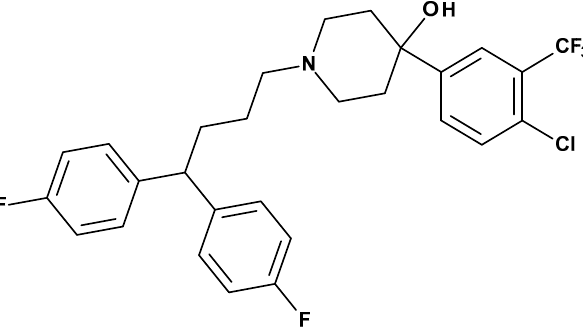
Figure 1. The chemical structure of penfluridol and some antipsychotic drugs.